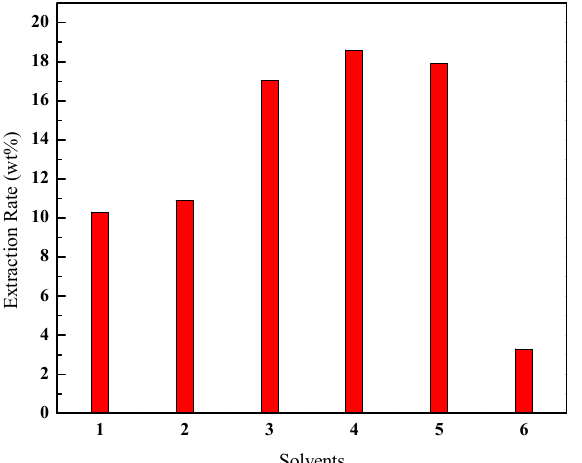
Figure 3. Effect of different organic solvents on the extraction rate of bitumen (1-petroleum Figure 3. E ff ect of di ff erent organic solvents on the extraction rate of bitumen (1-petroleum ether; 2- n-hexane; 3-cyclohexane; 4-toluene; 5-xylene; 6-ethyl alcohol).